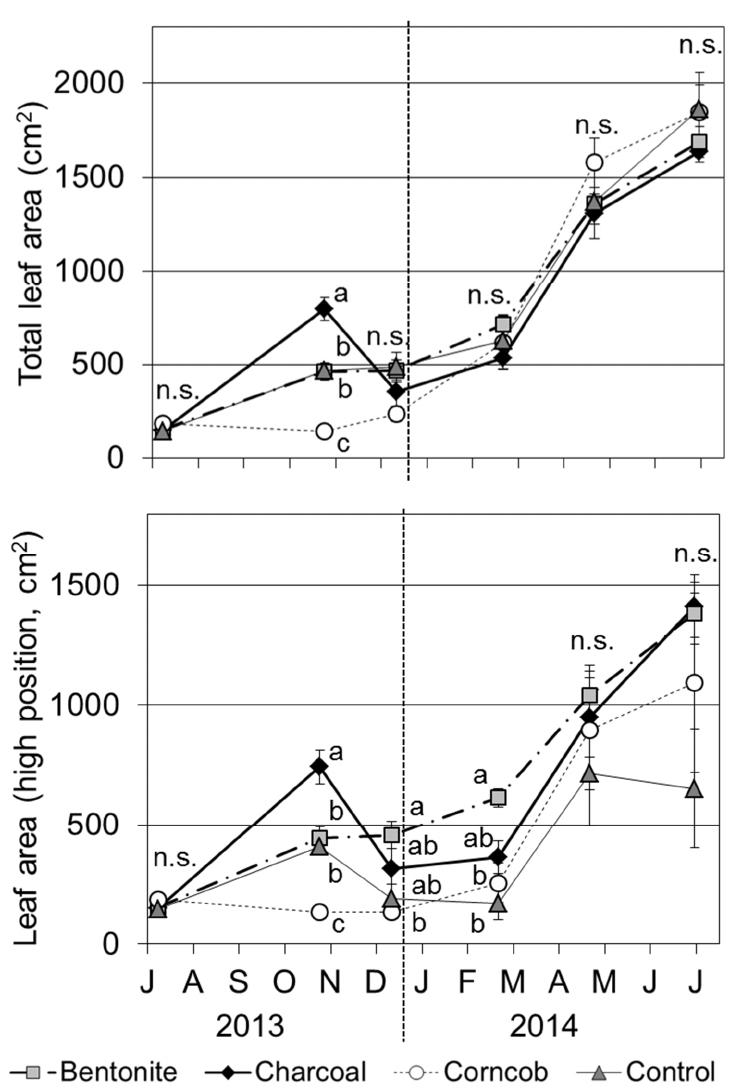
Figure 5. Total and high position (located at the top of stem) leaf areas for teak seedlings grown in the four treatments (Mean ± SE, n =